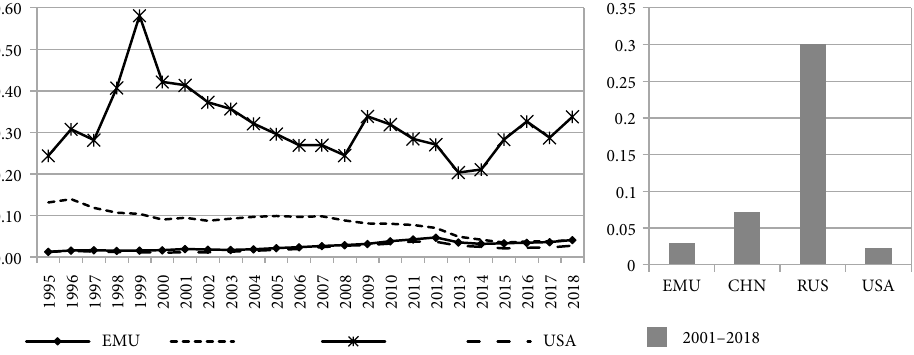
Figure 3. Relative size of i compared to other countries (source: own research based on WDI, 2020)